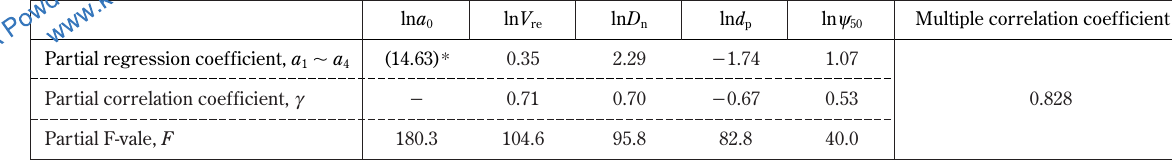
* ) denotes the value of ln a 0